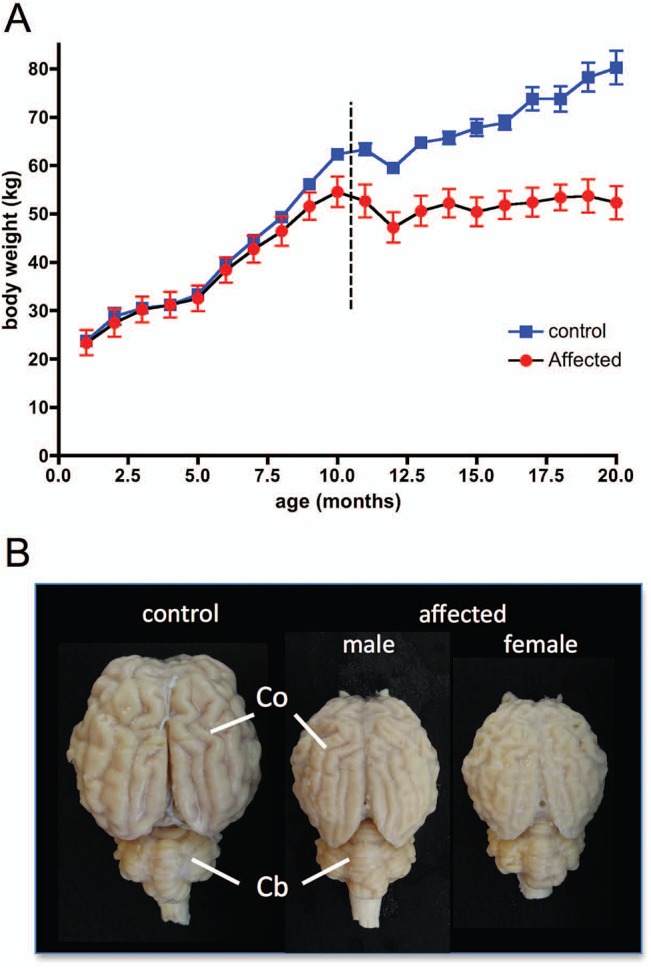
Batten disease affected sheep body weight changes and post mortem brain appearance.(A) Mean (± SEM) body weight of control (blue) and Batten disease affected sheep (red) from birth to 20 months of age shows that growth of Batten disease affected animals stopped at around 14 months. The dotted line indicates the time of transfer from the home farm to the MRI facility. (B) Comparison of gross anatomy of brains from a control sheep (left) and the least affected wether (male, 939), and least affected ewe (female, 937) (centre and right respectively) shows pronounced atrophy of the cerebral cortex (Co) with relative sparing of the cerebellum (Cb). Brains were fixed with 4% paraformaldehyde. Size bar in B represents 3cm.